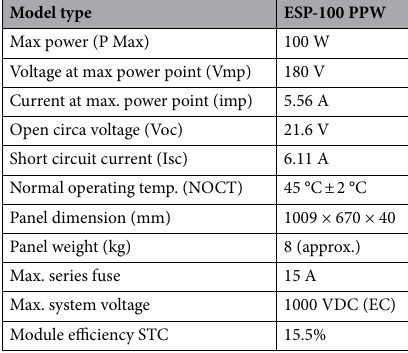
Table 1. PV panel data sheet.